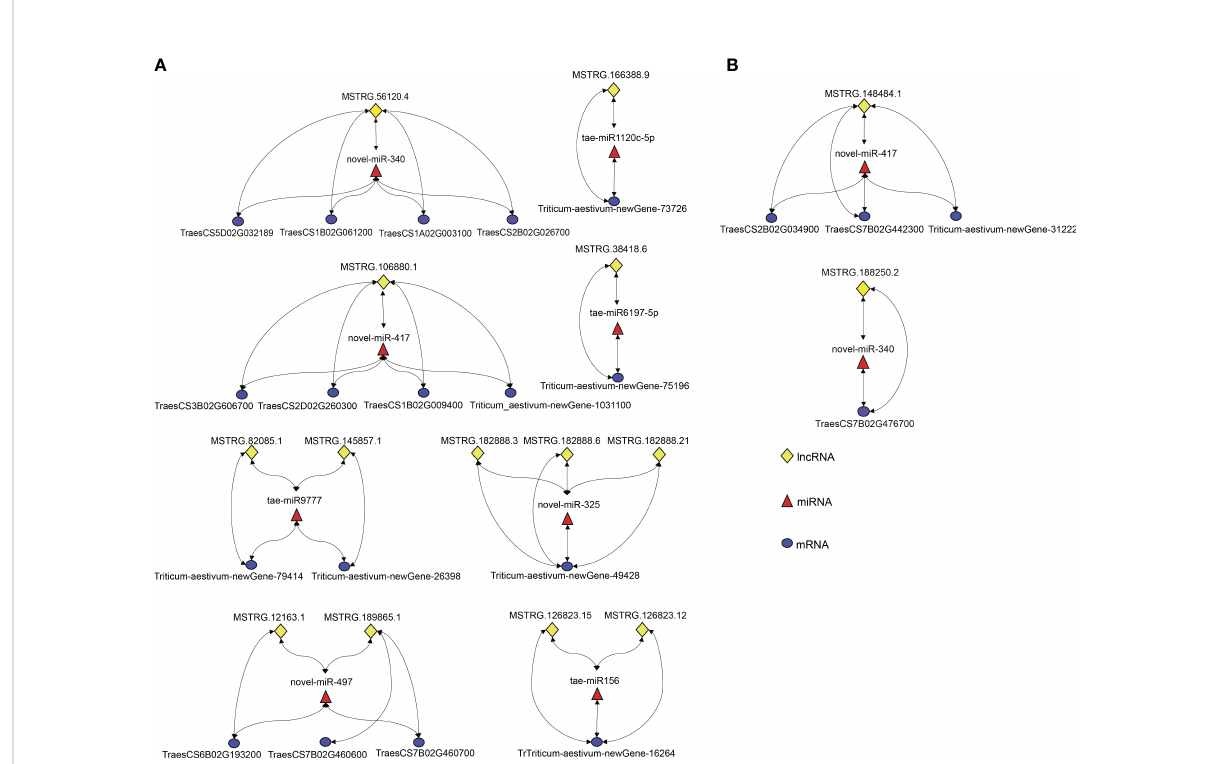
FIGURE 5 LncRNA-miRNA-mRNA regulatory modules associated with drought stress response were screened in DS (A) and DT (B) . Lines with arrows at both ends represent a targeting relationship between the two